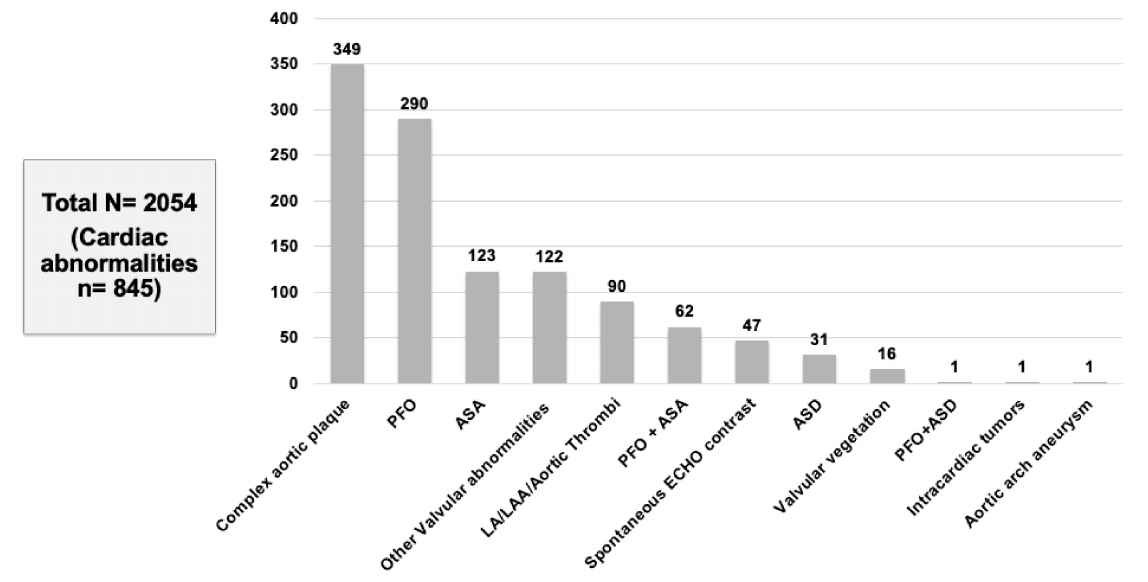
Figure 3. Cardiac abnormalities found on